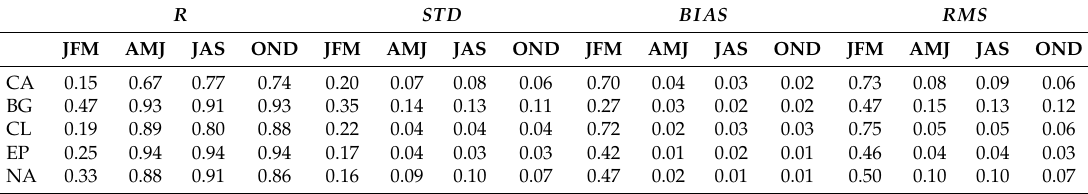
Table 1. Mean seasonal results of daily reconstruction validation under artificial clouds for year 2006. R STD BIAS